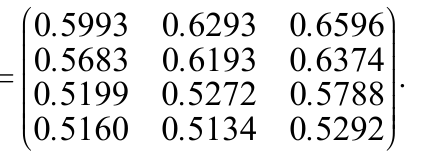
Table 6. Estimation of investor strategies and recommendations for choosing alternatives States of the economic environment Strategies